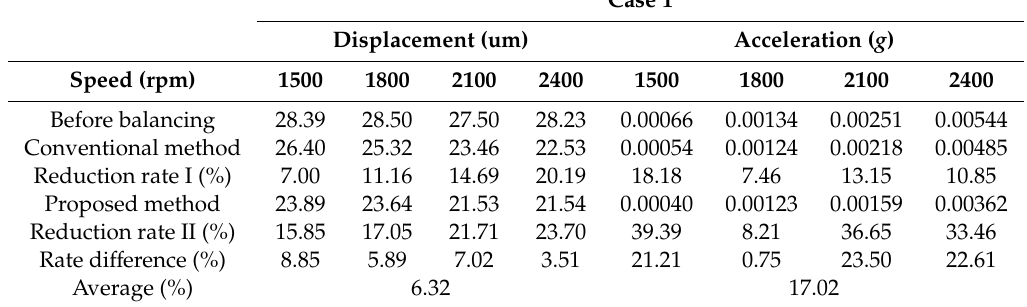
Table 6. Vibration reduction rate using the proposed method compared to conventional method.